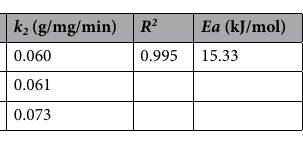
Table 5. Activation energy ( E a ) for sorption of nile blue onto GG-PAAm/Er 2 O 3